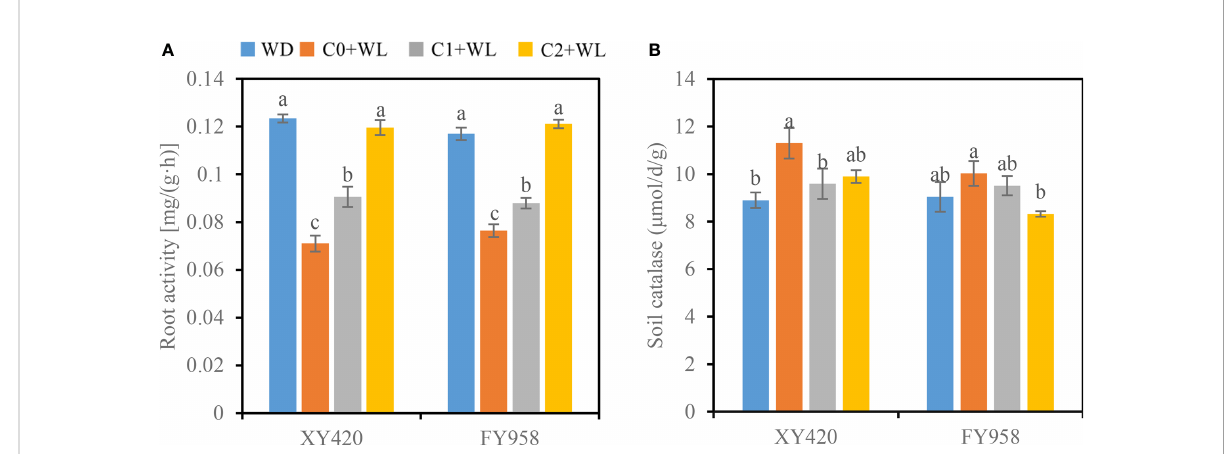
FIGURE 5 Effect of CaO 2 on root activity and the activities of soil catalase under waterlogging conditions. Error bars represent standard errors. (A) , root activity; (B) , soil catalase. Different letters above bars indicate signi fi cant differences between planting patterns at P < 0.05. WD,